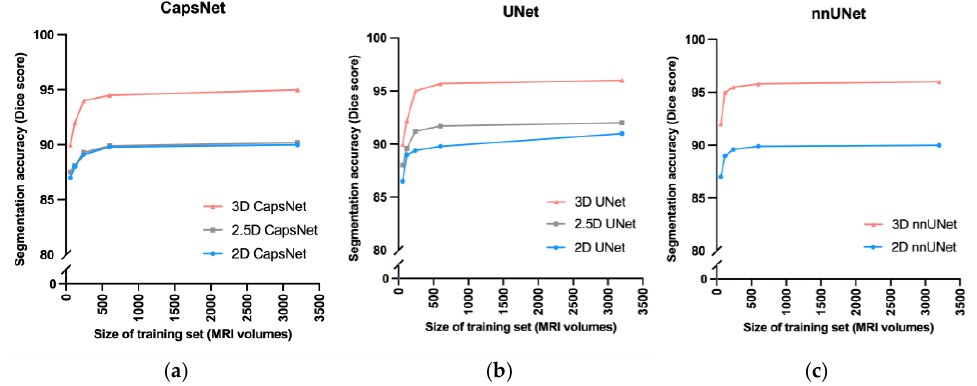
Figure 3. Comparing 3D, 2.5D, and 2D approaches when training data is limited. As we decreased the size of the training set from 3000 MRIs down to 60 MRIs, the CapsNet (a), UNet (b), and nnUNet (c) models maintained higher segmentation accuracy (measured by Dice scores).